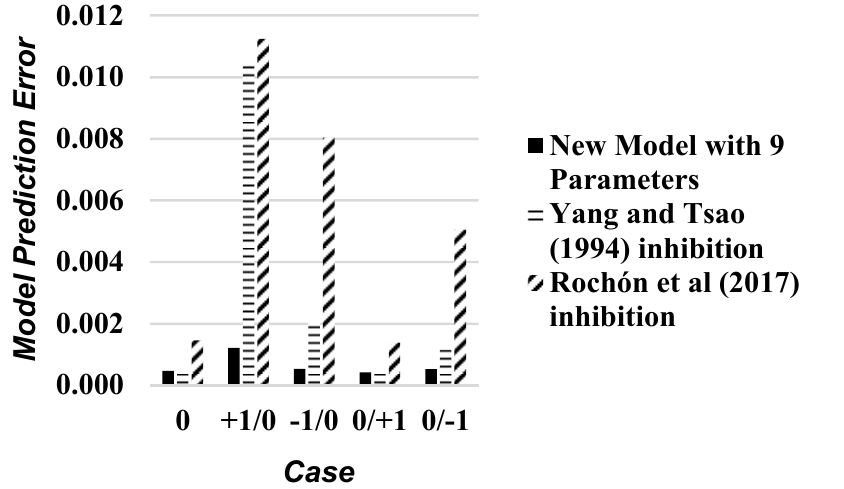
Figure 4. Sensitivity to input variables: adherence of Reduced-Model (9 parameters), Yang–Tsao- Model (17 parameters), and Rochón-Model (17 parameters) [6] over fermentation responses generated with the MV-Model for 120 h of ABE fermentation.